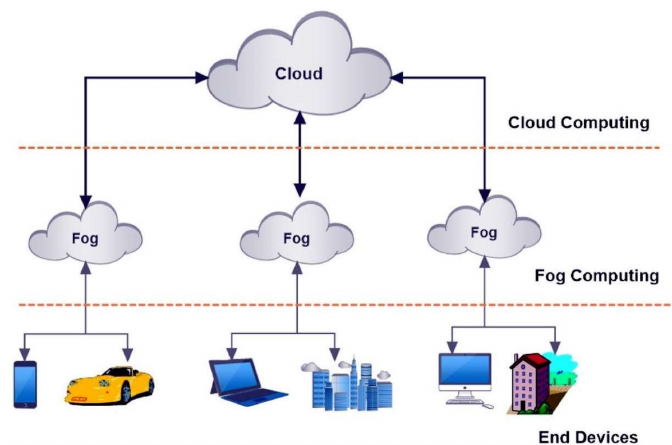
Figure 1. Fog computing is an extension of the cloud but closer to end